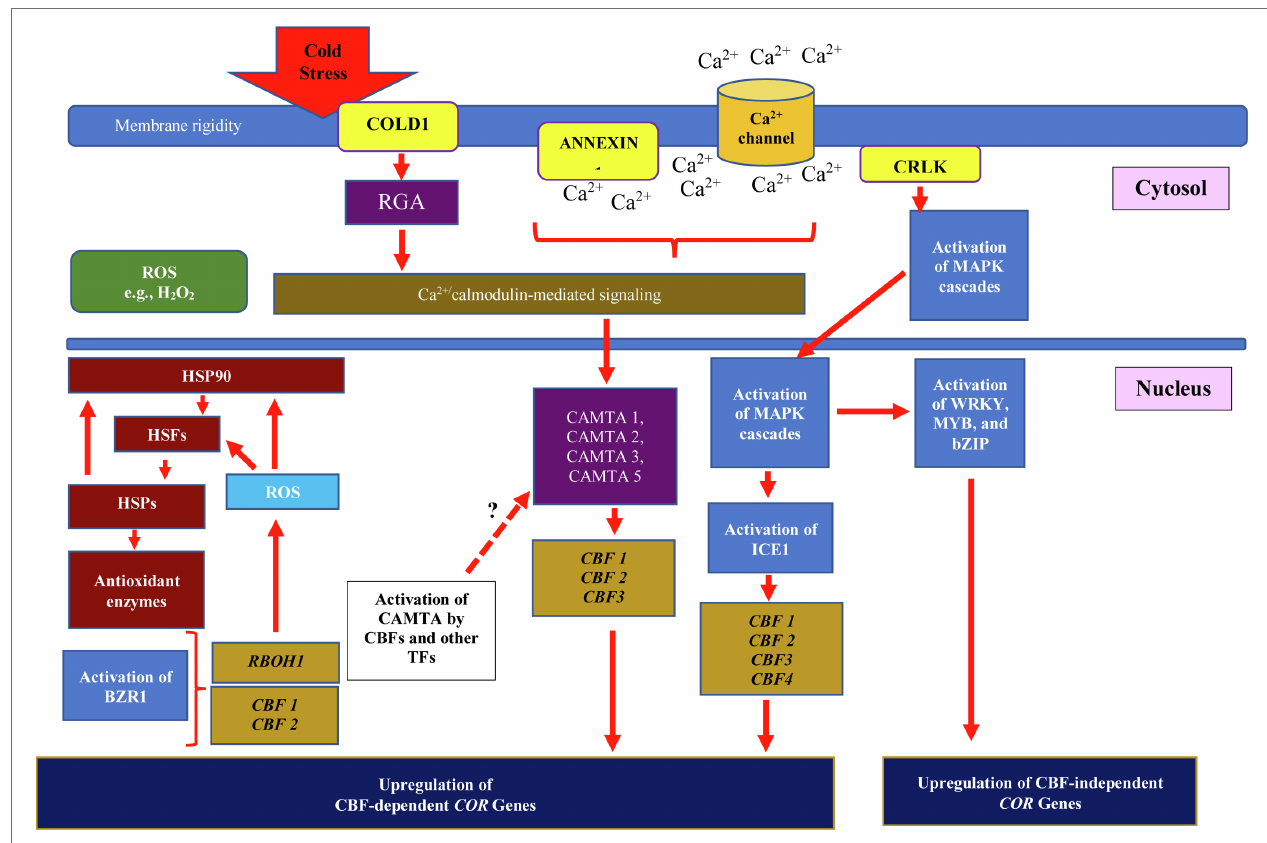
FIGURE 1 | Integration of cold, heat, and ROS signaling in CBF-dependent and independent pathways for regulating plant cold stress response. Cold stress triggers changes in membrane fluidity and rigidity, and activates the expression of cold-regulated genes ( CORs ) through CBF-dependent and independent pathways. The chilling tolerance divergence 1 (COLD1) receives external cold stress signal and stimulates rice G-protein A subunit 1 (RGA1) activity. This further activates ANNEXIN1, the Ca 2+ channels that transport Ca 2+ into the cell. The COLD1/RGA activity and Ca 2+ transmit cold stress signal to Ca 2+ /calmodulin-mediated signaling and Ca 2+ -dependent protein kinases (CDPKs) located in the cytosol. The CDPKs activities further convey cold stress signal through cytosolic and nuclear MAPKs signaling pathways, which leads to induction of ICE1 activity. ICE1 binds DRE/CRT motif in the promoter of CBF 1 , 2 , 3 , and 4 and upregulates their expression. Integration of cold signal through Ca 2+ /calmodulin-mediated signaling activates interaction between CAMTAs and CM2 motif located in CBF promoter, which further upregulates COR genes expression. The presence of ABRE, SARE, G-box, W-box, AuXRE, and DRE motifs in CAMTAs promoters suggests the potential regulation of CAMTA by CBFs and other stress-responsive transcription factors (TFs). Accumulation of brassinosteroids promotes binding of BZR1 to E-box found in CBF1 or CBF2 genes and activates the expression of COR genes. Through CBF-independent pathway, the expression of CBF-independent COR genes is regulated through interaction of other TFs such as WRKY, MYB, and bZIP. The expression of CBF-independent COR genes could also be regulated through ROS signaling pathway, involving ROS produced by RESPIRATORY BURST OXIDASE HOMOLOG 1 (RBOH1). The ROS further regulate heat shock factors (HSFs) and heat shock protein 90 (HSP90) and hence develop multi-chaperone network that controls production of antioxidant enzymes. The multi-chaperone network is also involved in controlling HSP90